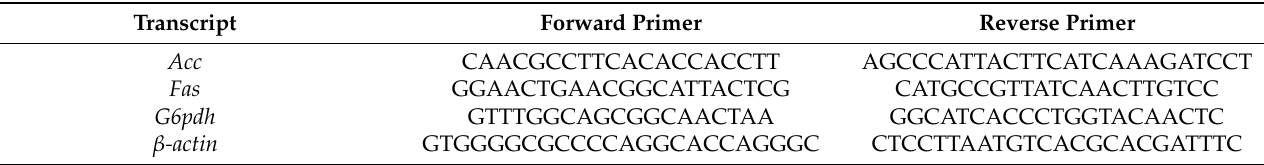
Table 2. RT-PCR primer sequences (5 (cid:48) to 3 (cid:48)